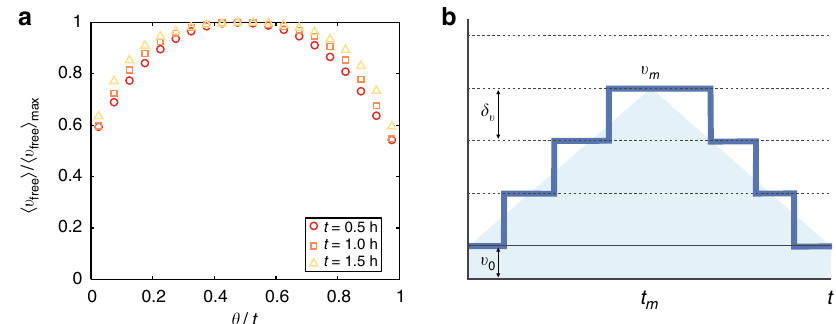
Figure 3 | Empirical evidence and schematic representation of the model. (a) We compute for different trips the empirical average free-flow speeds h v free i for the used roads, measured in the absence of congestion (see Methods section). We then aggregate the trips according to their duration t , and we plot the evolution of the relative average free-flow speed h v free i / h v free i max , where h v free i max is the maximal average free-flow speed reached at y E t /2. We observe symmetrical curves with a progressive increase of velocity in the first half of the trip, a short flat central part followed by a deceleration. The curves do not collapse, since longer trips have a larger fraction of their trajectory spent at a maximal speed. The maximal speed h v free i max is reached at the middle of the trip and increases from 79kmh (cid:2) 1 for trips with a duration t ¼ 0.5h to 106kmh (cid:2) 1 for a duration of t ¼ 1.5h. ( b ) Schematic representation of the random acceleration model (equation (3)). Each trajectory starts with an acceleration phase, where the speed increases by constant kicks equal to d v . These kicks happen at random times with an uniform probability per unit time p . When approaching the destination, there is a deceleration phase with random kicks of (cid:2) d v (with the same probability p ). The symmetry of the problem implies that the maximal speed v m is reached on average at t m ¼ t /2 and depends on d v and p : v m ¼ v 0 þ k ( t m ) d v , where k ( y ) is the number of kicks after a time y and follows a Poisson distribution of average h k ( y ) i¼ p y . The average speed (cid:2) v of the trajectory is evaluated by estimating the shaded area and leads to (cid:2) v ¼ ( v 0 þ v m